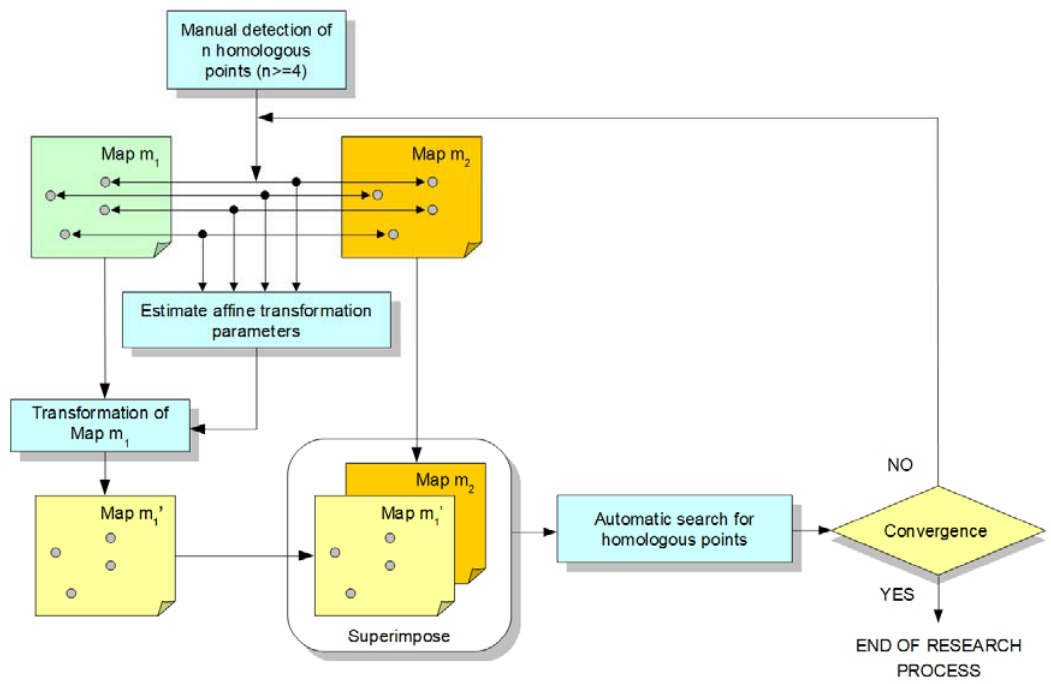
Figure 2. Homologous points detection algorithm.